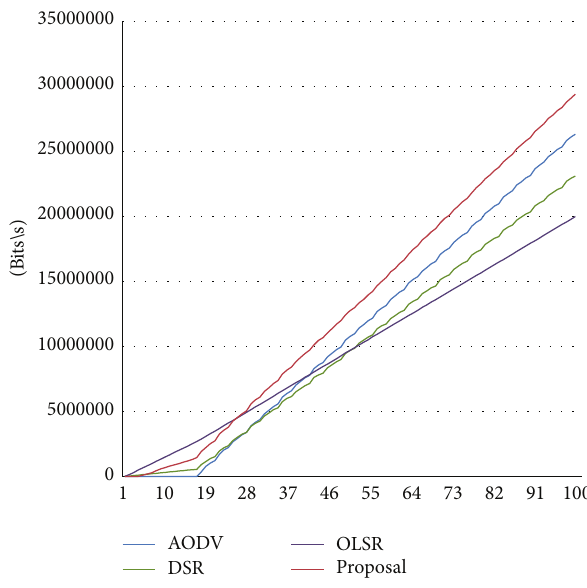
Figure 14: Comparison of